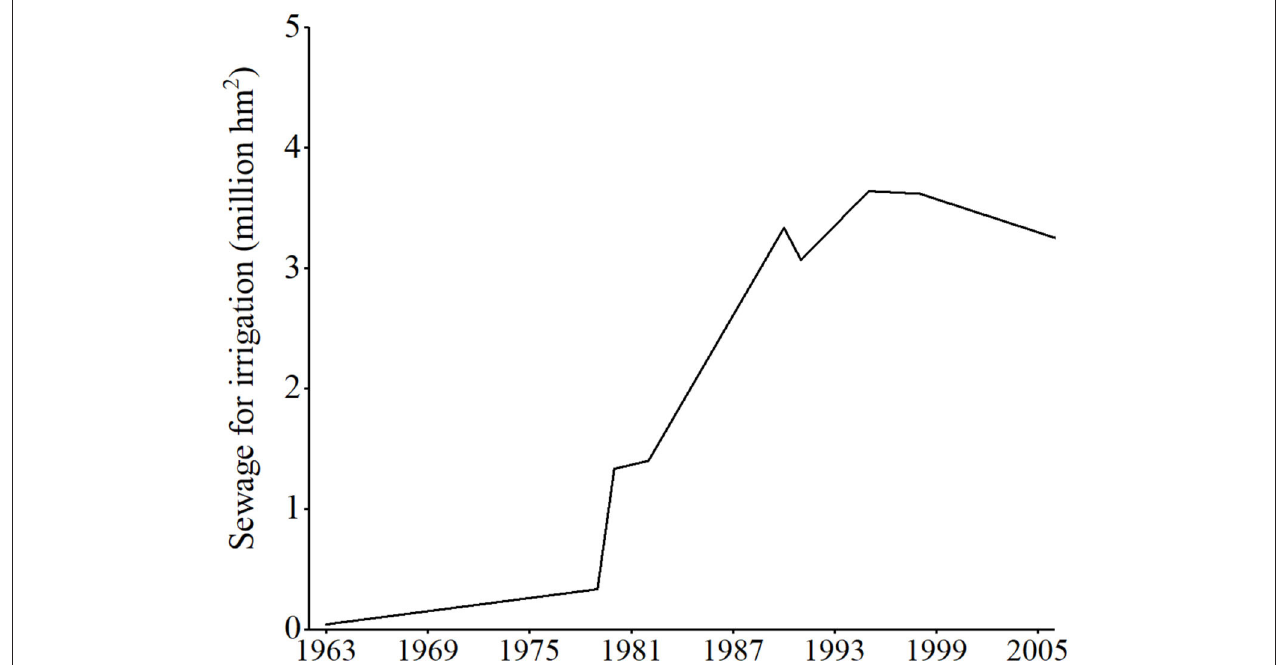
FIGURE 7 | The amount of sewage for irrigation in China. Data source: National Agricultural Environmental Quality Survey Cooperation Group of Sewage Irrigation Area (86), Yang (87), Liu and Xu (88), and Liu et al. (89).